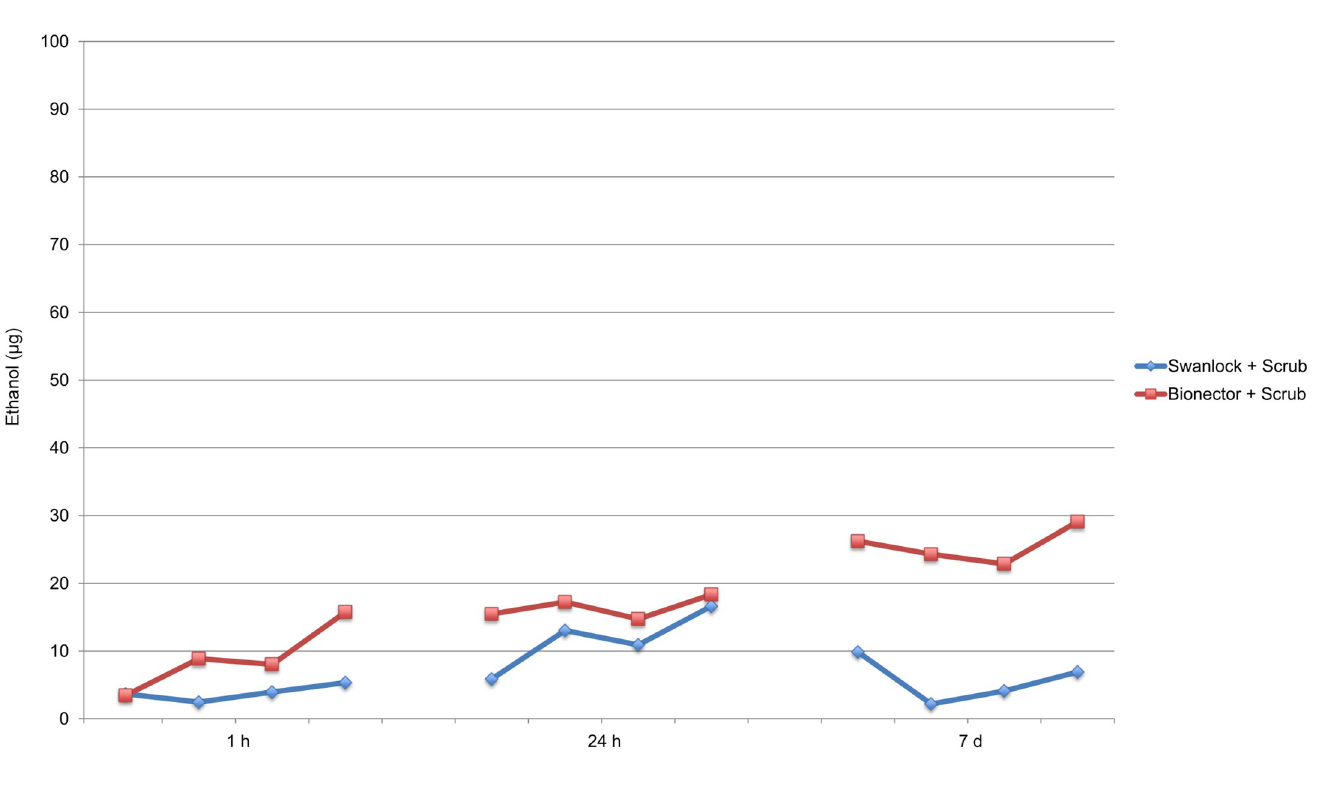
Fig 5. Ethanol leakage. Median amounts of ethanol derived from measurements of six replicates of each scrub circuit. The circuits with the same hub type are represented by the same color. The four dots per line illustrate a median value of each injection administered to the six circuits.